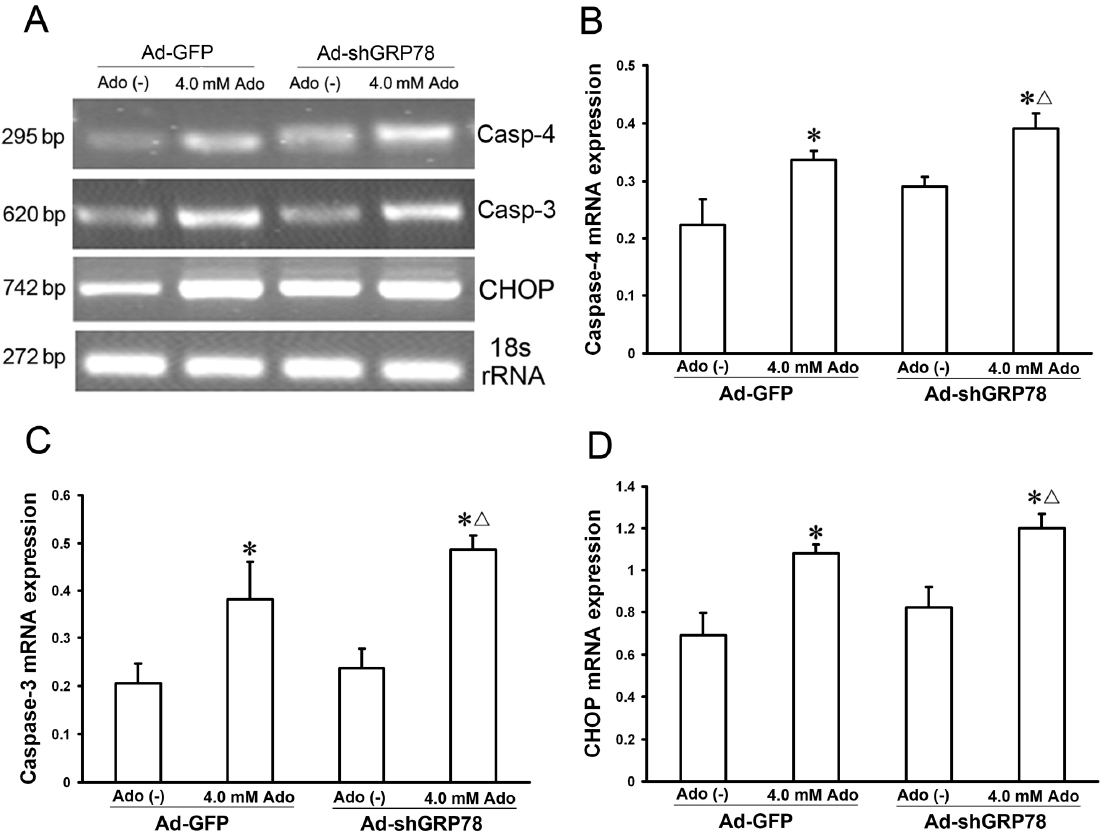
Figure 6. Effects of GRP78 knockdown on mRNA expressions of caspase-3, and -4, and CHOP. HepG2 cells were transfected with either Ad-GFP (control) or Ad-shGRP78. After incubation for 24 h, cells were incubated with or without 4.0 mmol/L adenosine for an additional 24 h. The cells were transfected with adenoviral vectors and without adenosine treatment as a negative control. The cells were transfected with Ad-GFP and with adenosine treatment as a positive control. Real-time PCR was used to detect mRNA expression ( A ); Adenosine caused increases in mRNA expression for all three genes. GRP78 knockdown further enhanced their mRNA expression following adenosine treatment ( B – D ). Data are presented as means ± SD of three independents